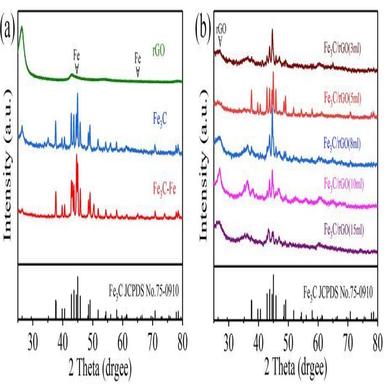
XRD patterns of a) rGO, Fe3C–Fe, Fe3C and b) Fe3C/rGO hybrids.